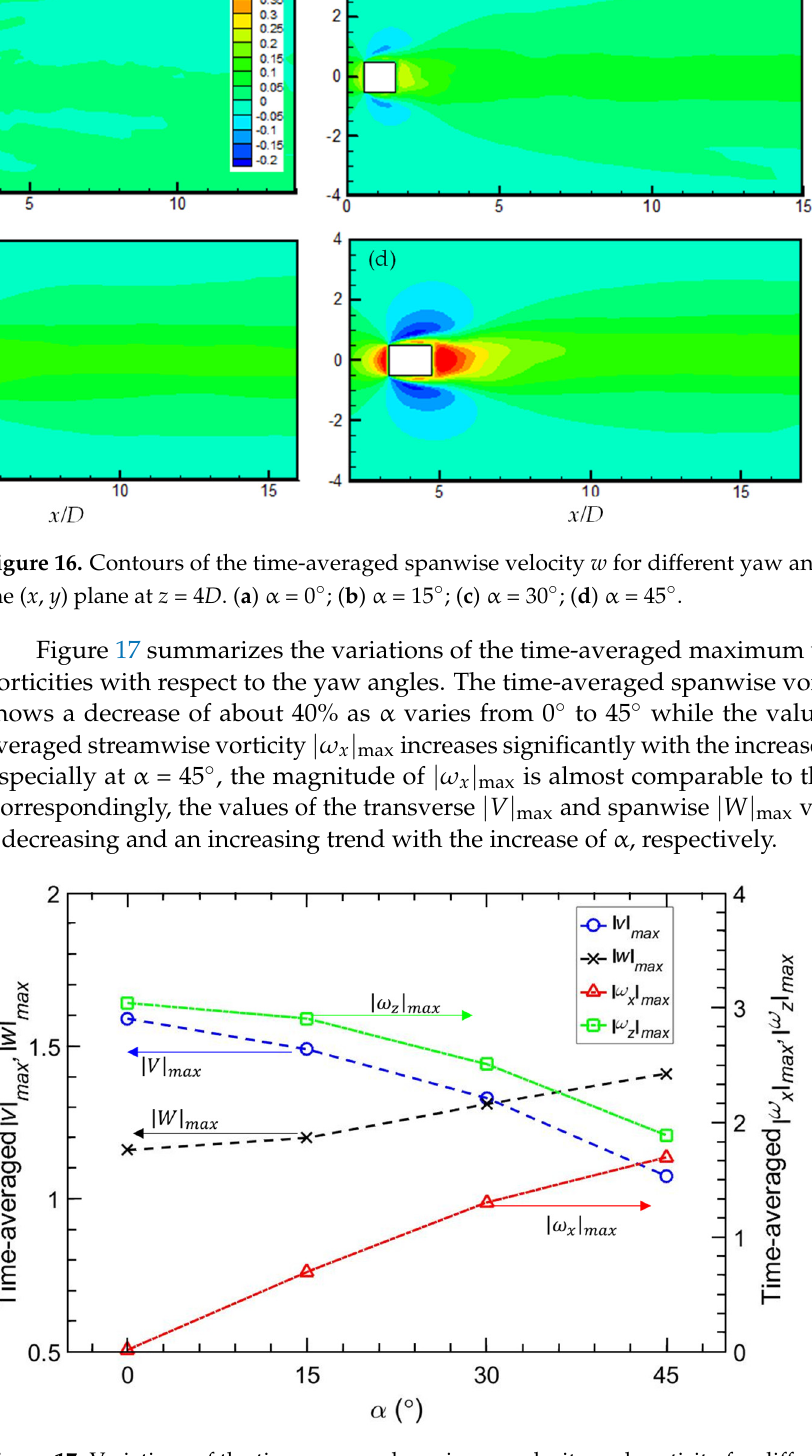
Figure 17. Variations of the time-averaged maximum velocity and vorticity for different yaw angles.